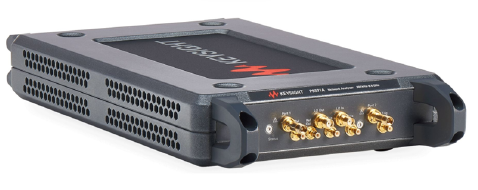
Figure 2. Network